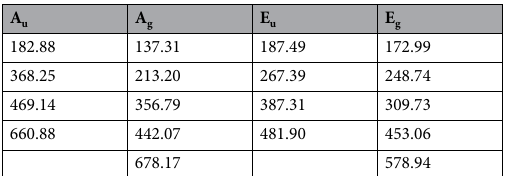
Table 3. The calculated frequency (cm − 1 ) of zone-center optical phonon modes of ilmenite (IL)-type ZnTiO 3 (space group R 3 ).